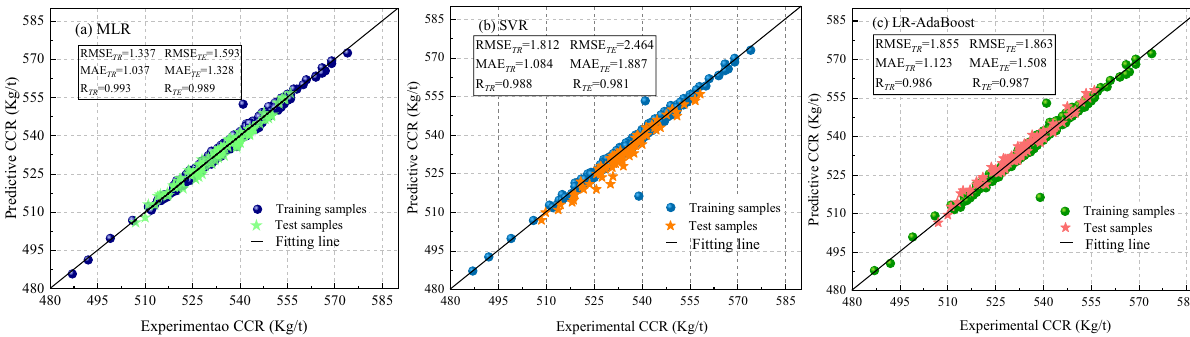
Figure 9: The scatter plots of the ( a ) MLR, ( b ) SVR, and ( c ) LR - AdaBoost